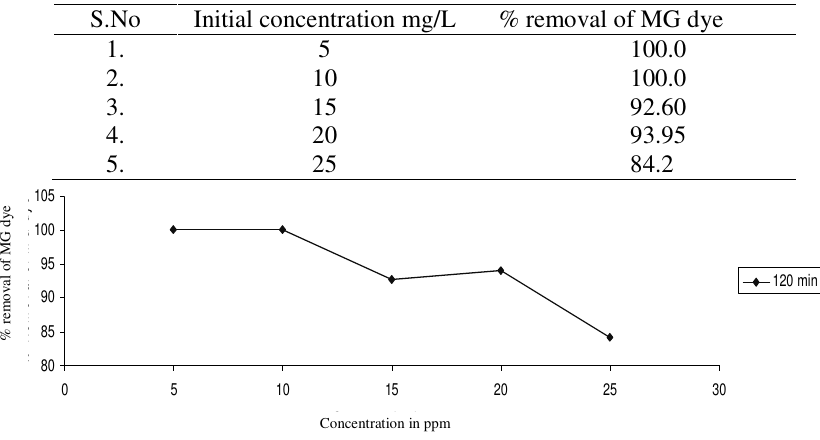
Figure 1 .Effect of initial concentration on removal of MG dye Effect of adsorbent dose